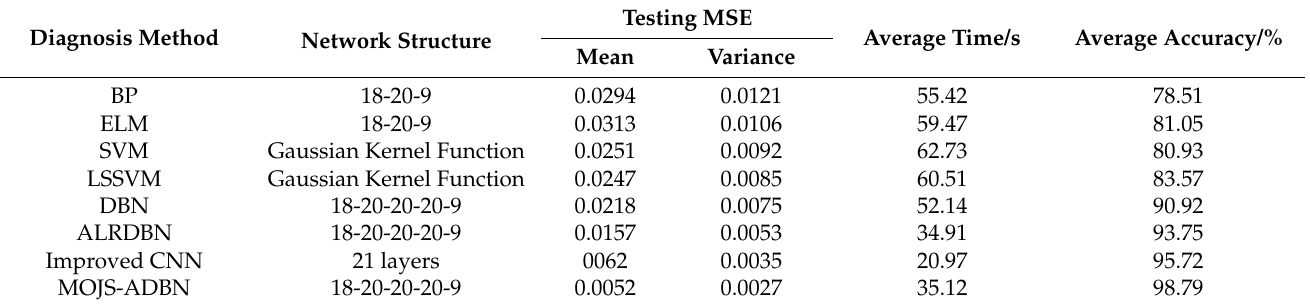
Table 3. Comparison of diagnostic performances of different models.